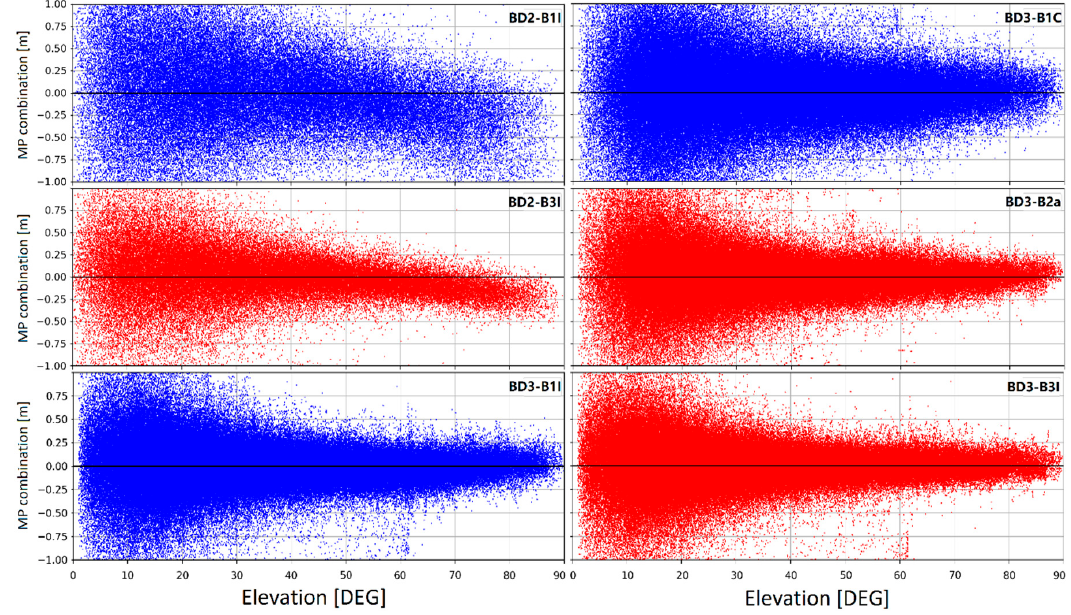
Figure 2. The BD2 and BD3 m edium Earth o rbit (MEO) satellites’ multipath combination versus